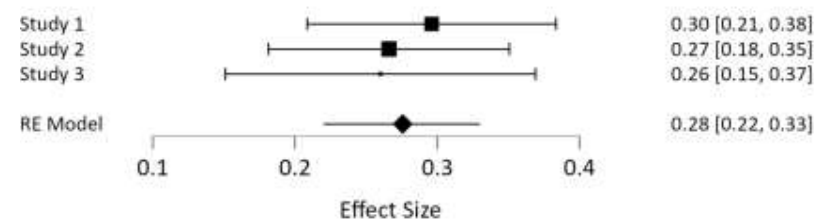
Figure 24. Forest plot of meta-analysis of Identified regulation and L2 test success